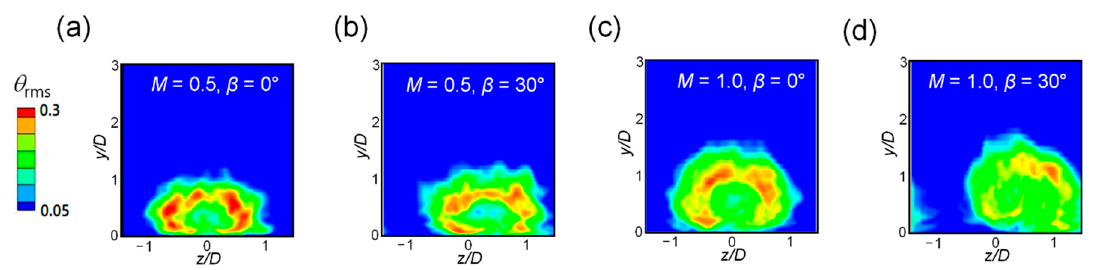
Figure 11. Temperature fluctuations obtained from the LES at x / D = 2.5: ( a ) M = 0.5, β = 0 ◦ ; ( b ) M = 0.5, β = 30 ◦ ; ( c ) M = 1.0, β = 0 ◦ ; and ( d ) M = 1.0, β = 30 ◦ . Processes 2021 , 8 , x FOR PEER REVIEW